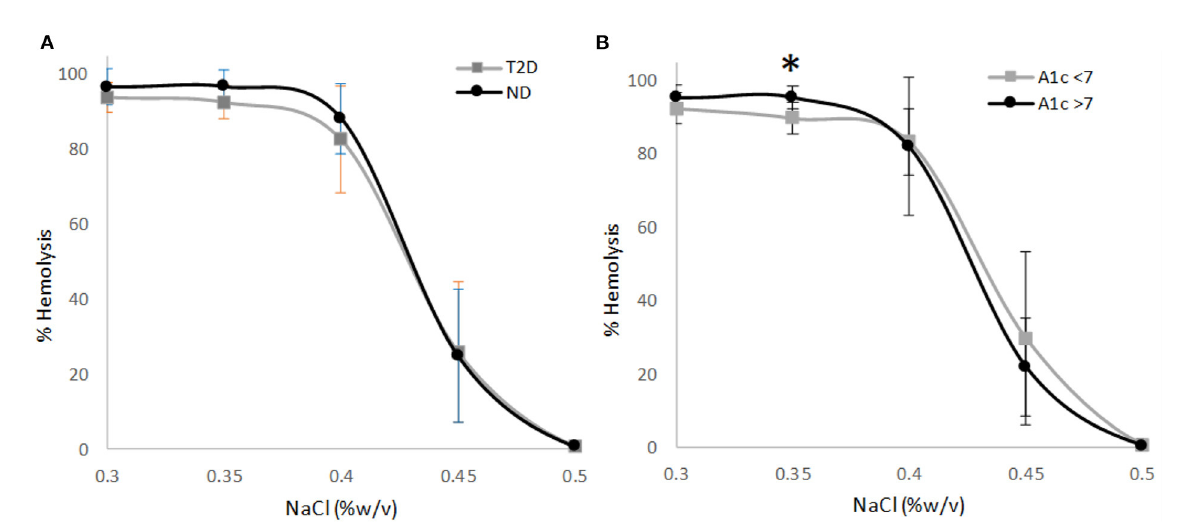
FIGURE1 (A) Osmotic erythrocyte fragility in participants with type 2 diabetes (T2D; n = 14) or normal glucose tolerance (ND; n = 16) as a function of NaCl concentration ( p = 0.090). (B) Osmotic erythrocyte fragility in the T2D participants grouped by hemoglobin A1c status as a function of NaCl concentration ( n = 7/group; p = 0.031). Data points represent mean ± SD; p -values represent multivariate analysis controlling for age and BMI. Asterisk denotes a significant difference between groups ( p <